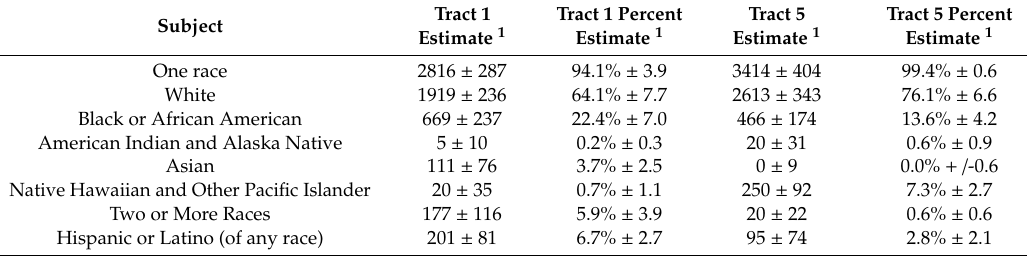
Table A2. Select Categories from ACS Demographic and Housing Estimates. 2013–2017